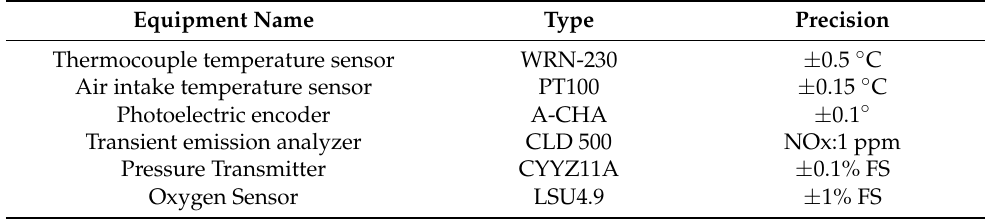
Table 2. Measuring devices of the engine test